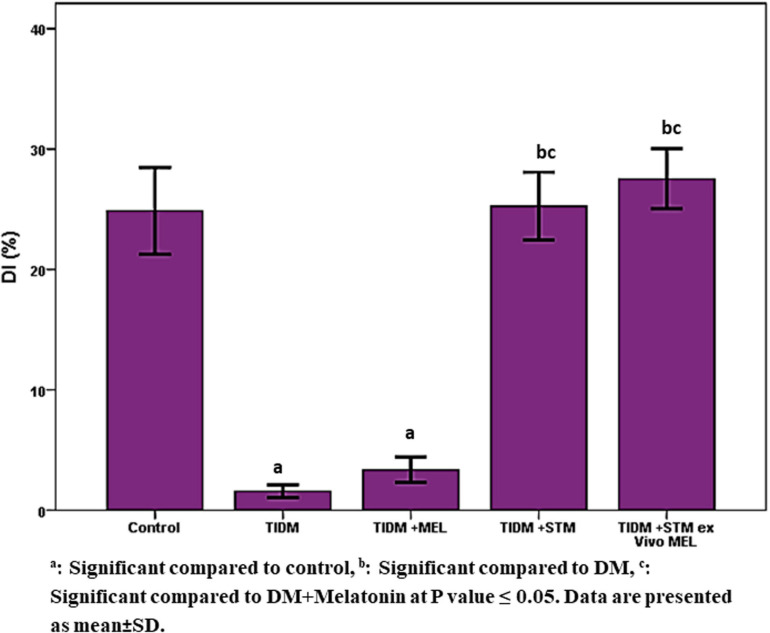
Discrimination index in novel object recognition task (NORT) in the studied groups. [DI = (Novel Object Exploration Time/Total Exploration Time) – (Familiar Object Exploration Time/Total Exploration Time) × 100]. aSignificant compared to control, bsignificant compared to DM, csignificant compared to DM + Melatonin at P-value ≤ 0.05. Data are presented as mean ± SD.